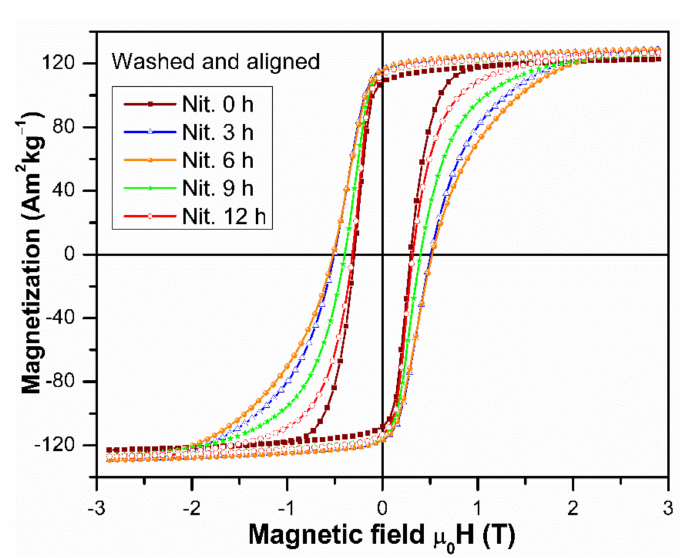
Figure 6. Hysteresis loops of the Nd 1.1 Fe 10 CoTiN x alloys nitrogenized for the indicated time, washed, and magnetically oriented.